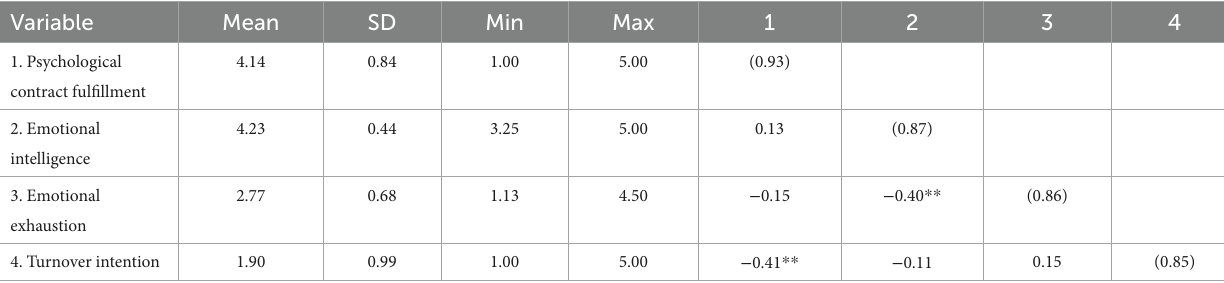
TABLE 1 Descriptive statistics and